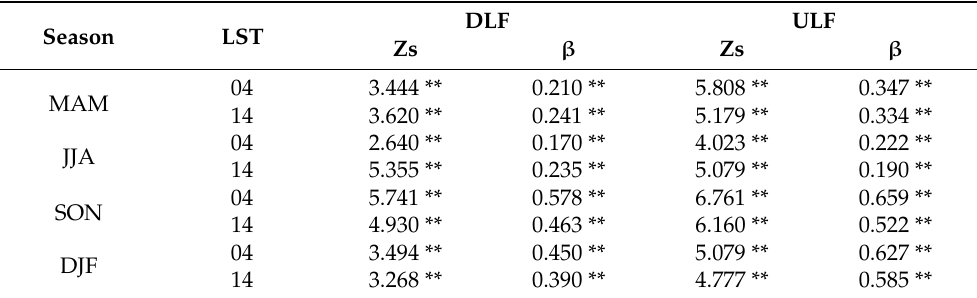
Table 3. Results derived by the Mann–Kendall and Sen’s slope statistical tests for seasonal DLF and ULF during